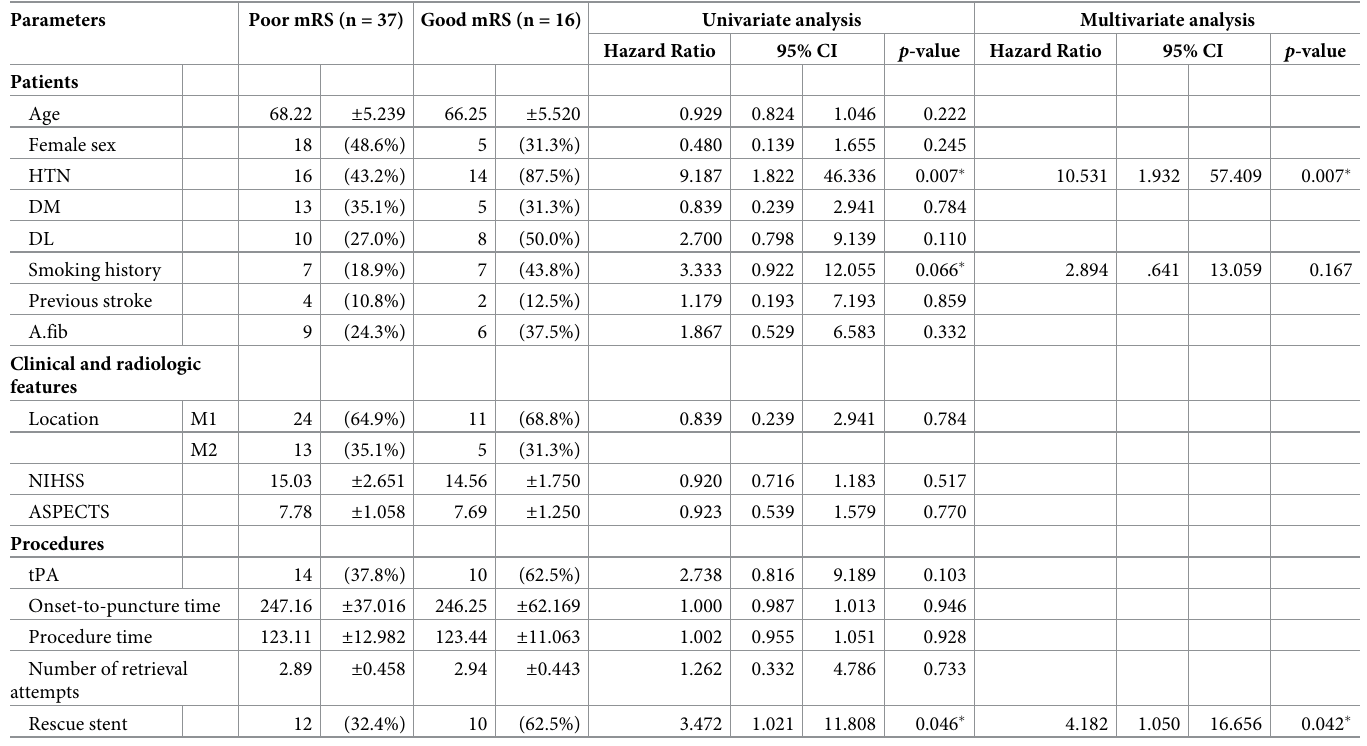
Table 2. Results of univariate and multivariate analyses for identifying factors associated with good functional outcomes (3-month mRS 0–2).